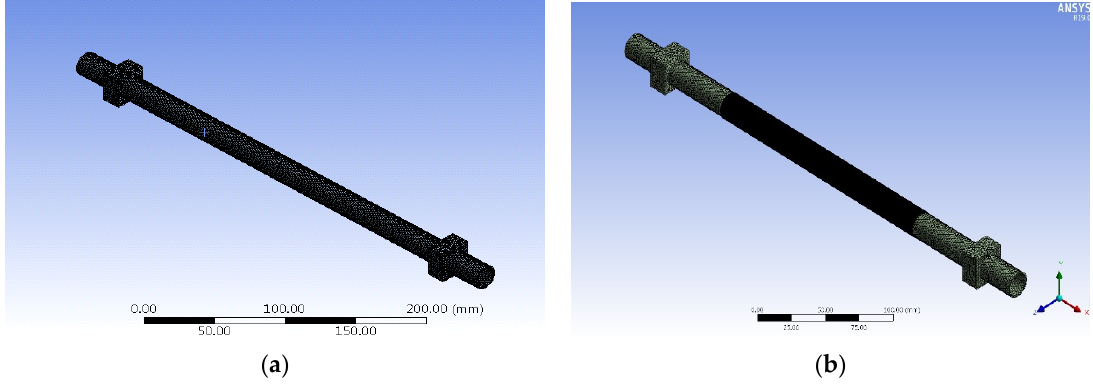
Figure 3. Grid classification. Figure 4. Model meshing ( a ) without the hard coating and ( b ) with the hard coating.